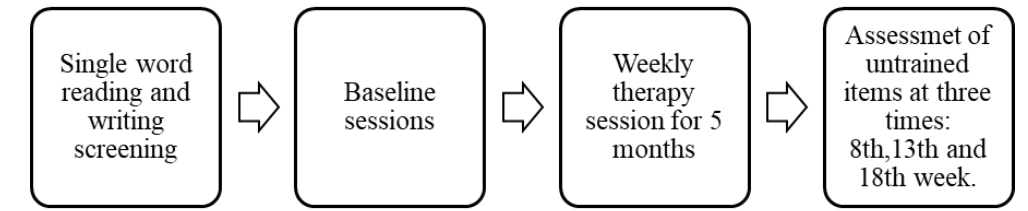
Figure 2. Timeline of the single subject multiple-baseline design.